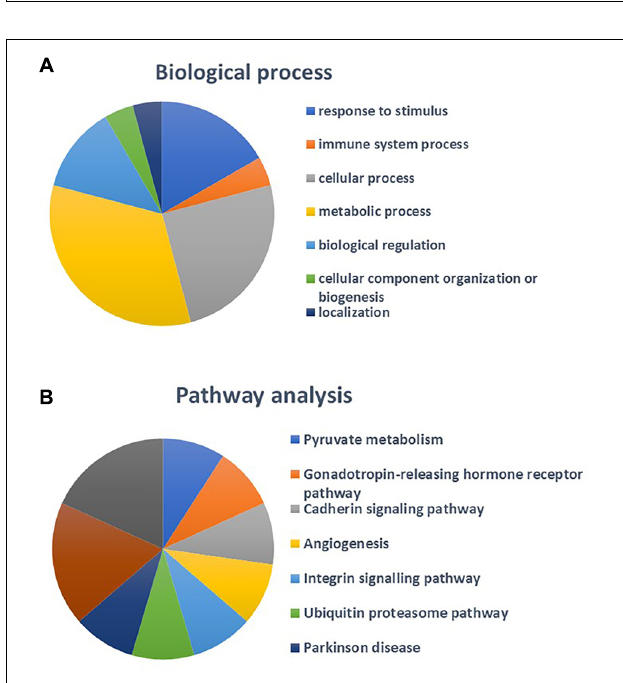
FIGURE 7 | Biological processes (A) and pathway analysis (B) of identified mitochondrial proteins.